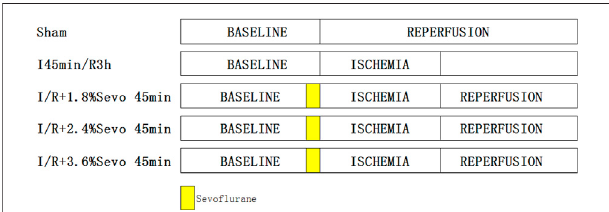
FIGURE 1 | Rats in each group.In the sham group, the silk suture was passedunderLADwithoutligation.TheothergroupswereligatedwithLADfor 45 min and then reperfused for 180 min. Sevo fl urane groups with different concentration of sevo fl urane was inhaled with corresponding concentrations for 45 min before